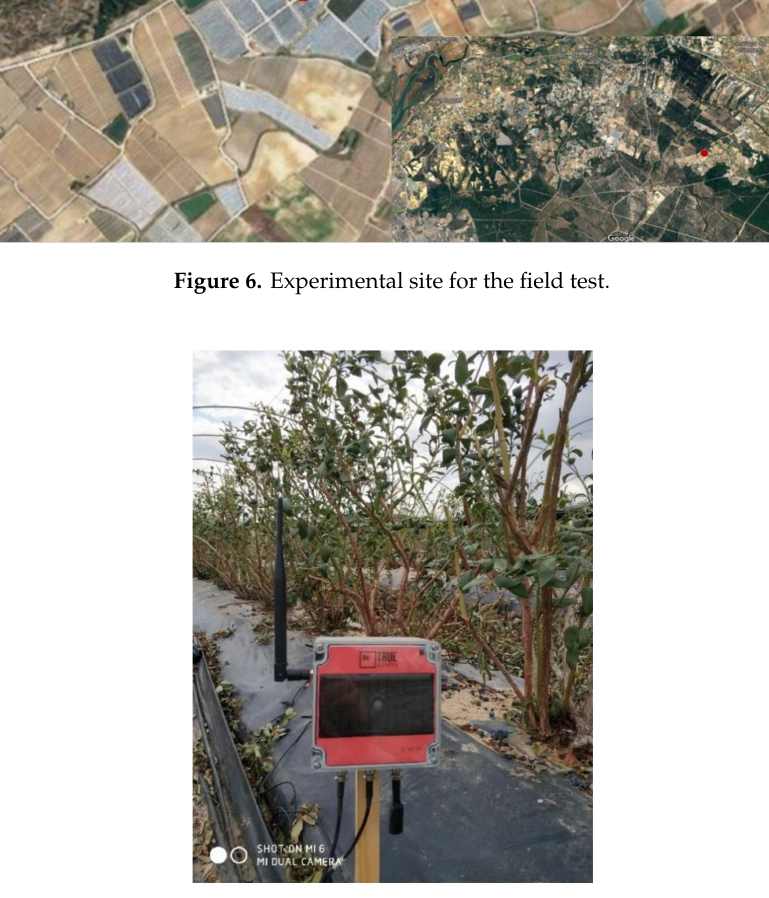
Figure 7. Installed device taking measurements every 30